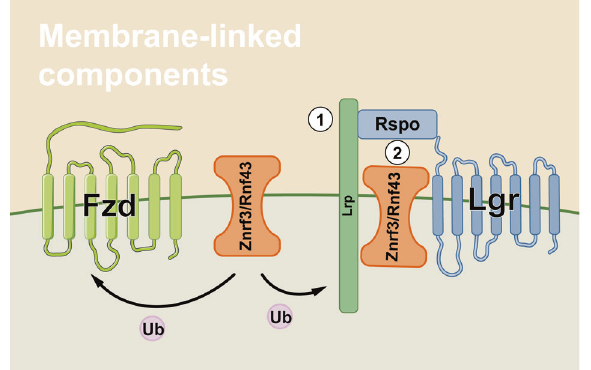
Fig. 2 The membrane-linked components and signaling transduc- tion of Wnt/ β -catenin signaling. Ub ubiquitin, ① the switch-on of Fzd/Lrp ubiquitination, ② the switch-ff of Fzd/Lrp ubiquitination via Rspo